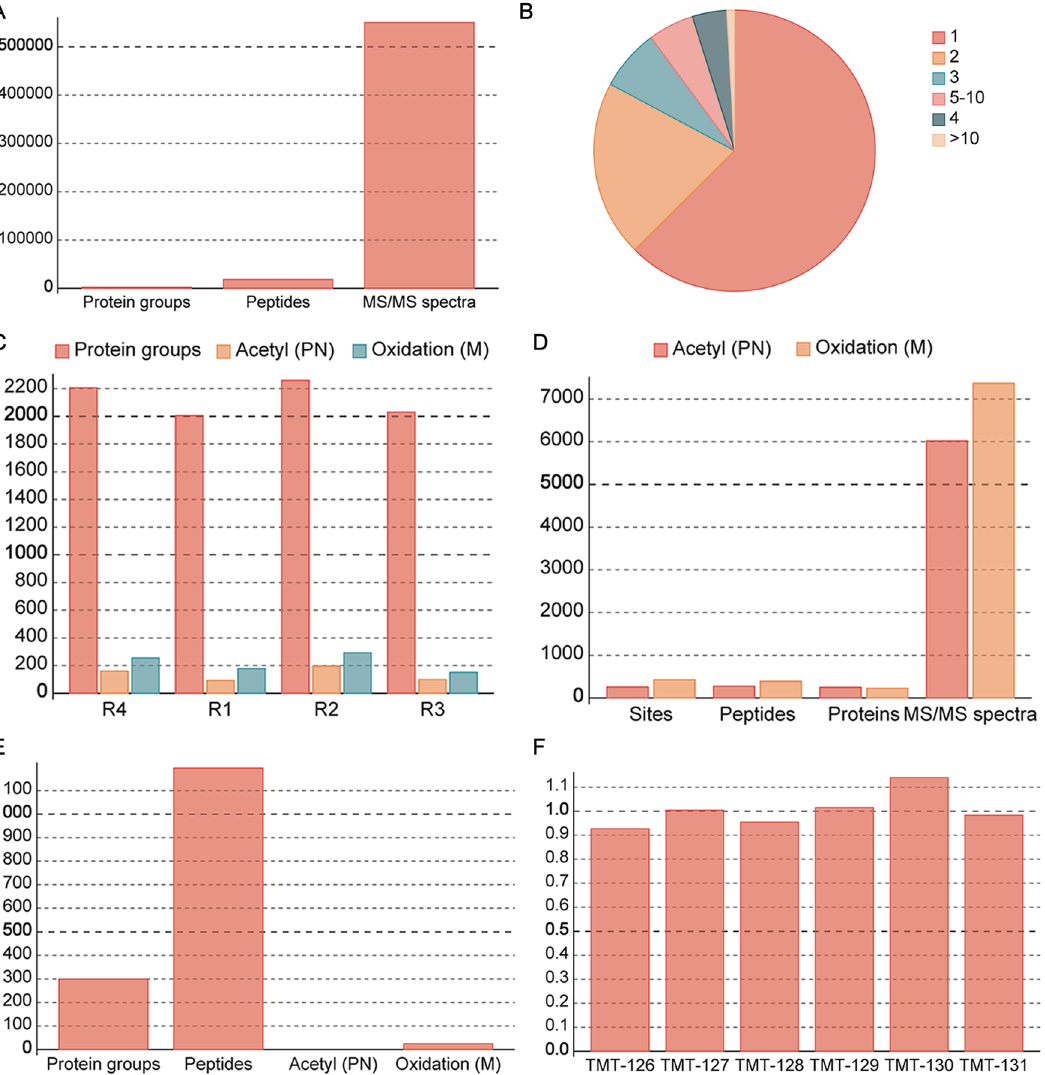
Fig 2. Examples of statistical charts. MaxReport automatically generates various statistical charts for both identification and quantification results including: summary of proteome identification (A); distribution of site counts (B); summary of experiment specific identification (C), PN stands for protein N- terminal. M stands for Methionine residue. R represents different experimental replication; summary of PTM specific identification (D); summary of quantification results (E) and overall calibration factors (F).